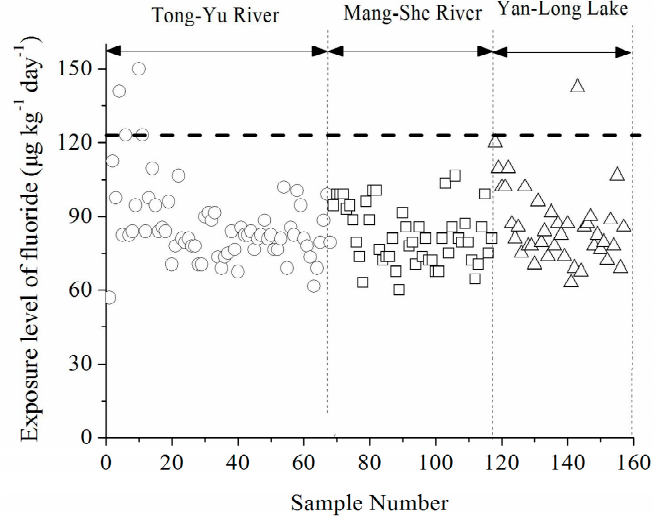
Figure 4. Exposure of fluoride for infants in the three drinking water sources of Yancheng City. Note: Dashed line in Figure 4 refers to the toxicity reference value of 122 µ g kg − 1 d − 1 , which is recommended by Health Canada.